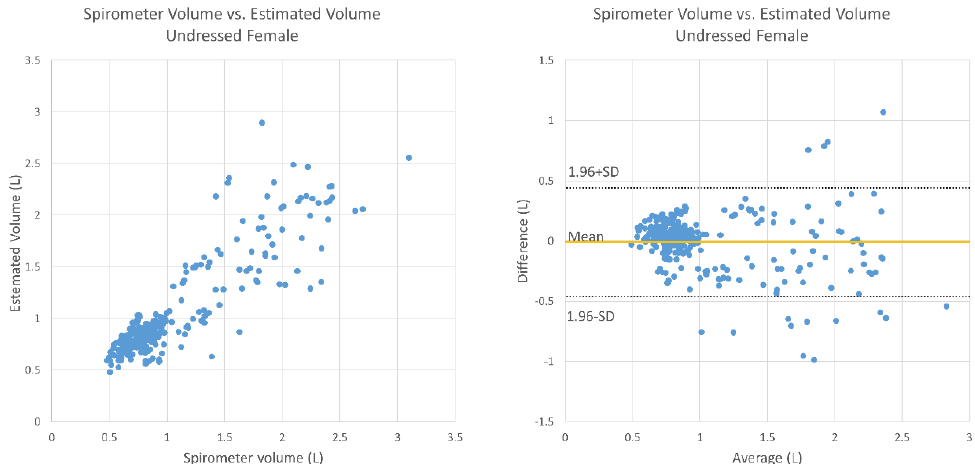
Figure 8. Bland–Altman plot for TV obtained using the spirometer and the estimated TV under undressed conditions (female subjects).